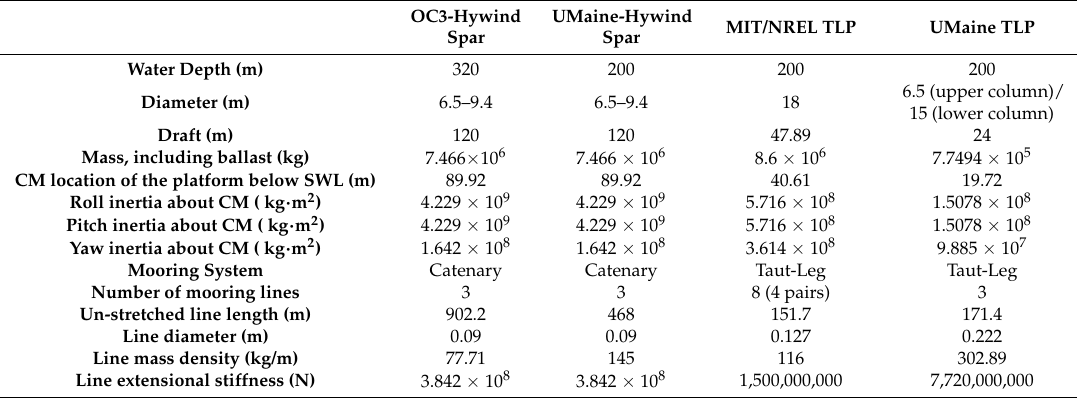
Table 1. Main particulars of floating platforms and mooring systems (SWL: seawater